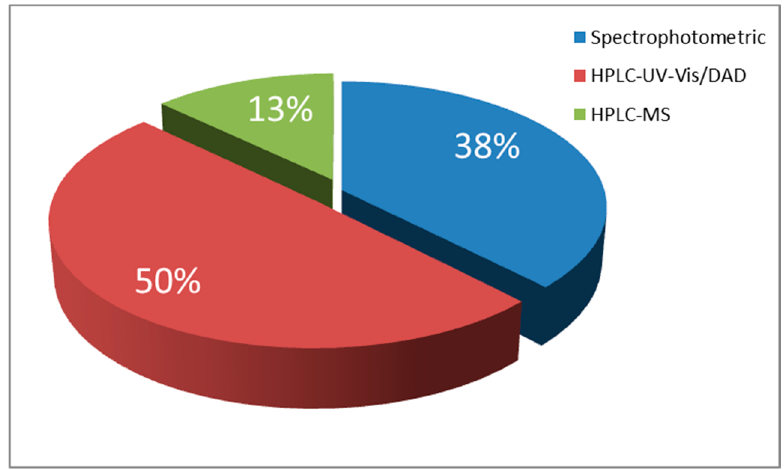
Figure 2. Distribution of techniques used for the analysis of natural food colorants.